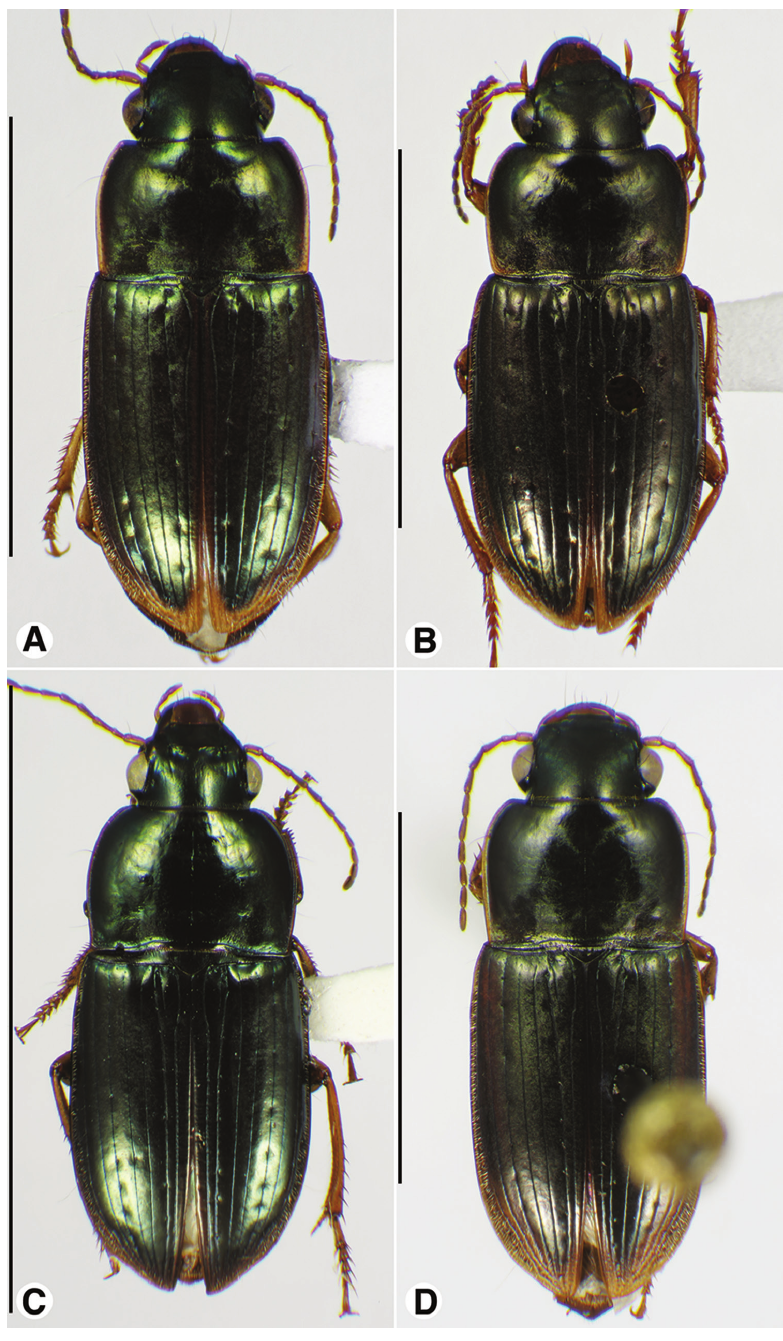
Figure 49. Habitus digital images of Selenophorus palliatus species group, dorsal aspect. A S. alternans Dejean B S. palliatus (Fabricius) C S. pyritosus Dejean D S. woodruffi , Ball & Shpeley. Scale bars: A, B, D 5 mm; C 10